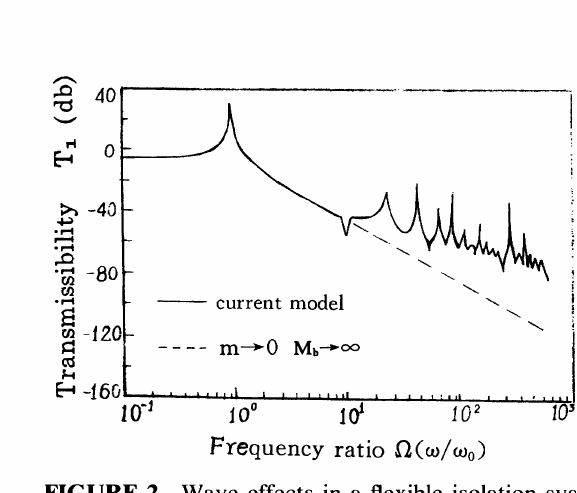
FIGURE 2 Wave effects in a flexible isolation sys tem: 'YI = 50, 'Y/ = 0.2, 'Y = 0.01, A = 10, M1Mb = 10.